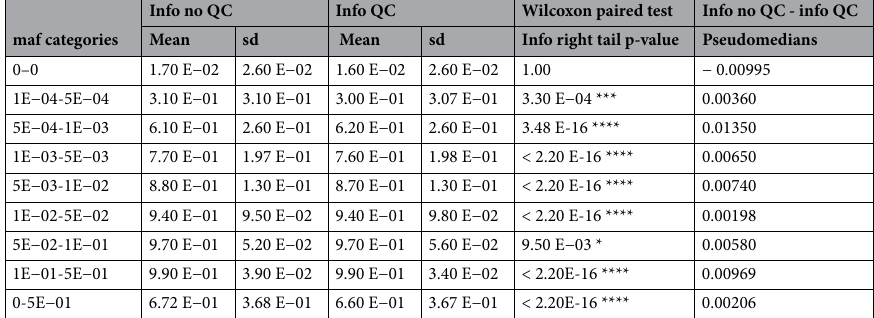
Table 2. One tail Wilcoxon-paired signed rank test comparing information before (no QC) and after QC (QC). Significant differences in information scores were found in each class except the first category as null alleles hold no information. Right tail levels of significance **** < 0.00005, *** < 0.0005, ** < 0.005, * < 0.025. The differences between the two distributions were at least equal to their pseudomedians (pseudomedians were obtained from the differences between the distributions before and after QC). Info information imputation score, maf minor allele frequency, sd standard deviation, QC quality control.